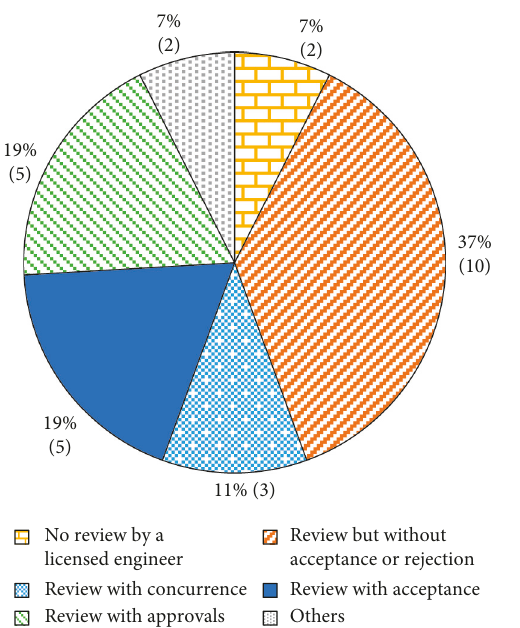
Figure 4: Number of states conducting various degrees of oversight to accept bridge demolition plans